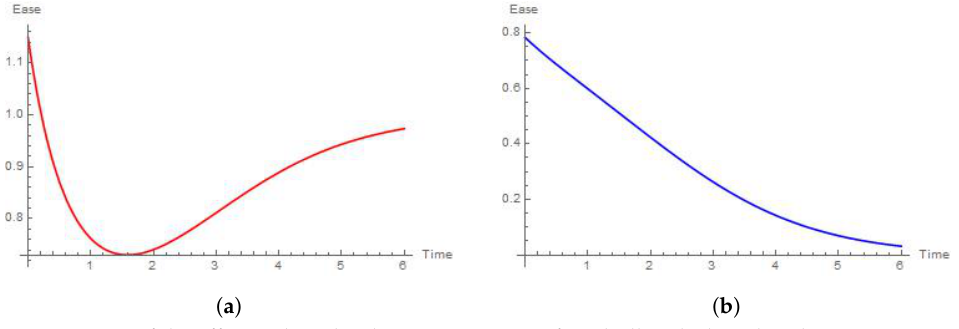
Figure 17. Ease of the efforts when the shape parameters of Weibull and Chen distributions are δ 1 = 2 and δ 2 = 1, respectively. ( a ) Ease of the effort required Weibull extractor when δ 1 = 2. ( b ) Ease of the effort required Chen extractor when δ 2 =